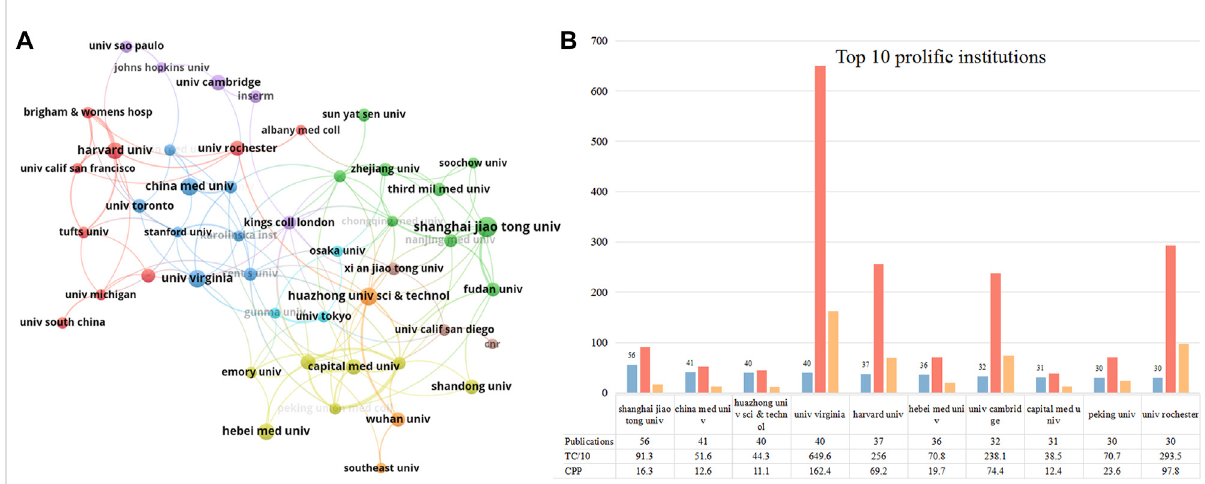
FIGURE 4 The top 10 most productive institutions and inter-institutions ’ co-operative network. (A) Collaboration among these proli fi c institutions which published more than 15 papers. Node size indicates the number of publications. The width of links re fl ects the cooperativestrength. (B) The number of publications, total citations (TC), and citations per publication (CPP) in the top 10 proli fi c